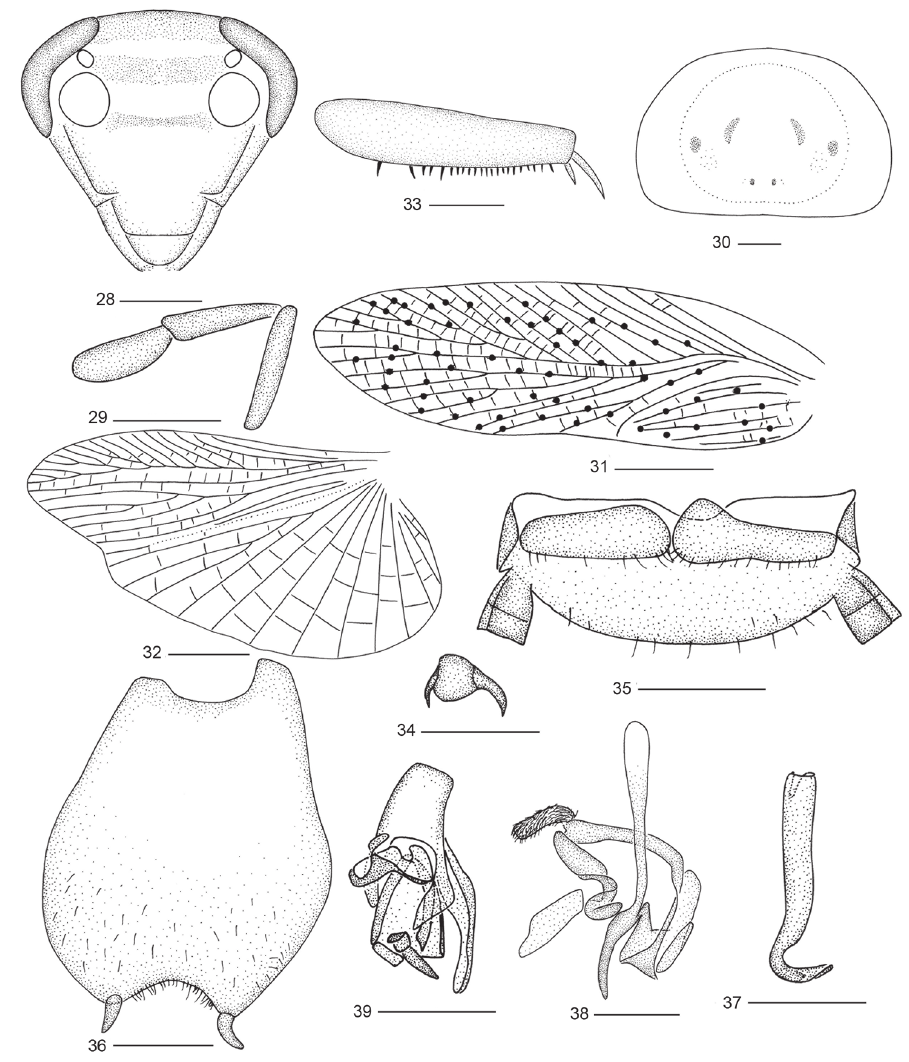
Figures 28–39. Balta maculata sp. n. 28 head 29 maxillary palps 30 pronotum 31 tegmen 32 hind wing 33 front femur 34 tarsal claws and arolium 35 supra-anal plate and paraprocts, ventral view 36 subgenital plate, dorsal view 37 right phallomere 38 median phallomere 39 left phallomere. Scale bars: 0.5 mm ( 28–30, 33–39 ), 2.0 mm ( 31, 32